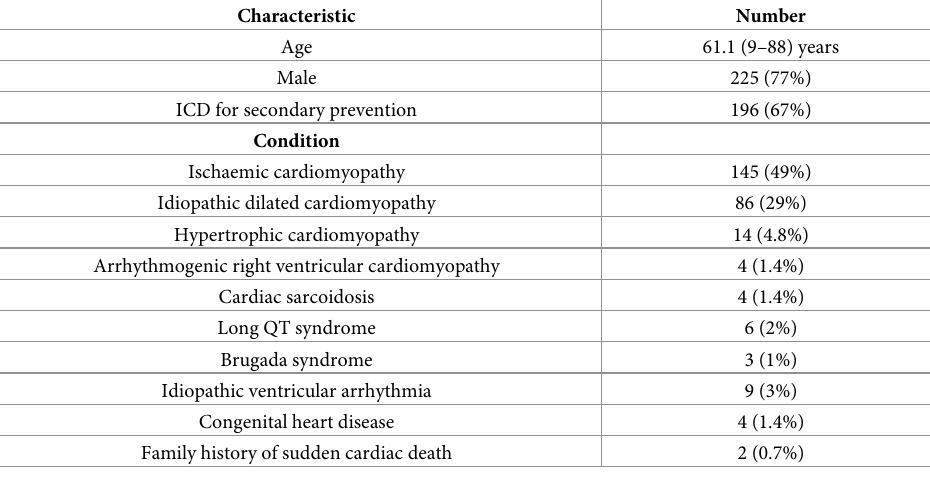
Table 1. Baseline patient characteristics and underlying conditions requiring implanted defibrillators.